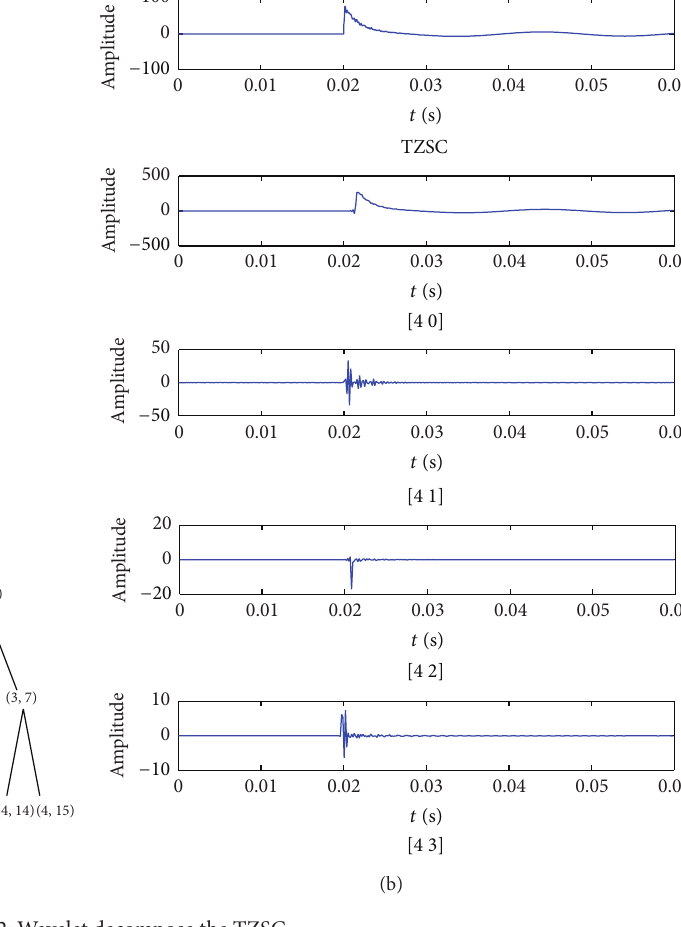
Figure 12: Wavelet decompose the TZSC. Table 11: Wavelet relative energy